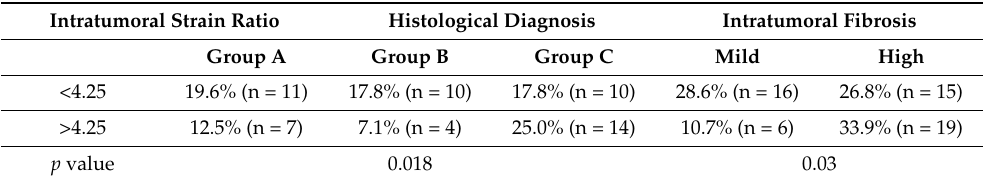
NS not significant. Table 3. Intratumoral strain ratio of malignant mammary carcinomas according to their histopatho- logical features.